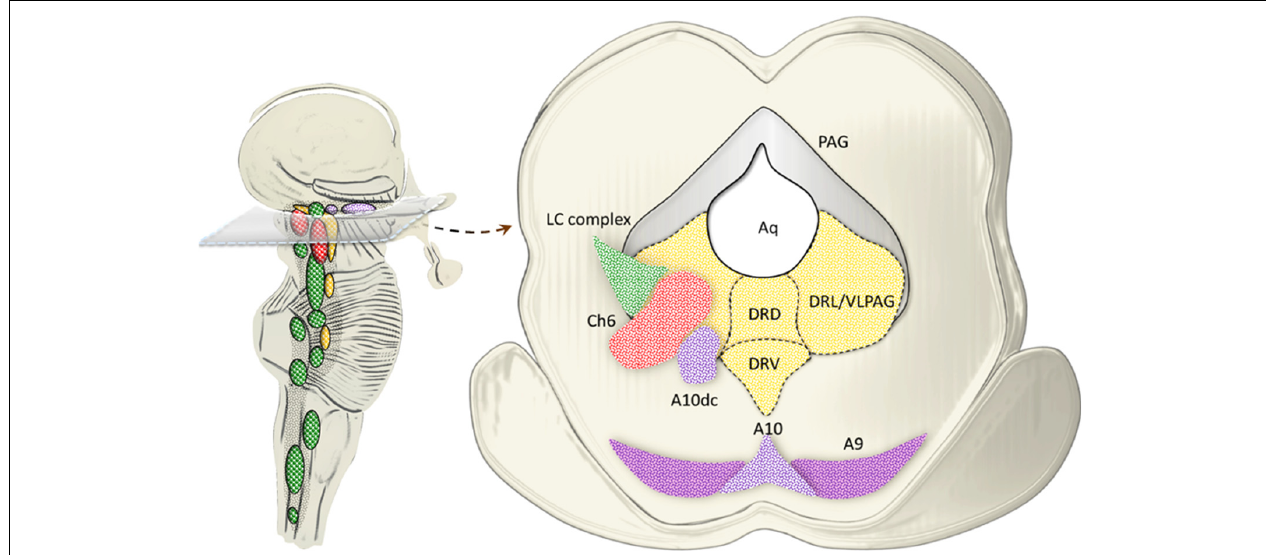
FIGURE 7 | Catecholamine and cholinergic nuclei of the dorsal raphe/PAG. The dorsal raphe nucleus extends from the rostral pons up to the midbrain within and around the ventromedial and ventrolateral PAG. In fact, at this level, three sub-regions of the dorsal raphe intermingling with PAG are identified, namely, dorsal (DRD), ventral (DRV) and lateral (DRL; Steinbusch et al., 1981; Baker et al., 1990, 1991). While 5-HT neurons are scattered throughout all the dorsal raphe, the ventromedial and mostly the ventrolateral PAG (VLPAG) hosts a mixed neuronal population, among which catecholamine and cholinergic neurons prevail at large. This is the case of the NE nucleus epicoeruleus corresponding to the rostral and dorsal extent of the LC complex. Similarly, DA neurons of the A10dc nucleus, as well as cholinergic neurons of the Ch6 (LDTg) intermingle in the DRL/VLPAG with their rostral